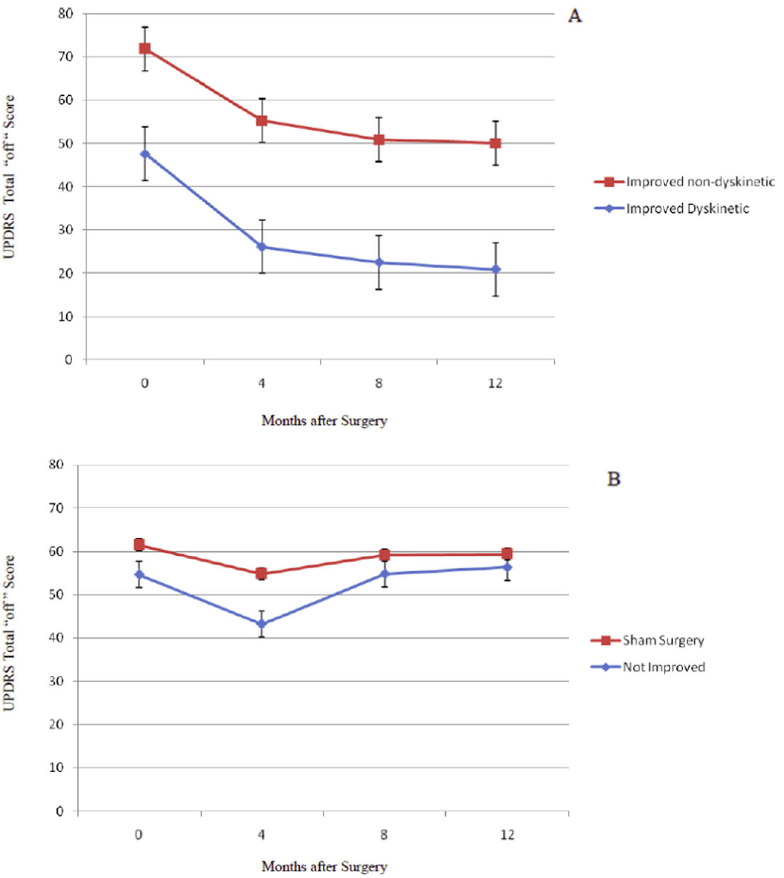
Fig. 1 Change in Total UPDRS “ off ” scores for younger transplant and sham surgery patients. The graphs present the results only in the younger 21 subjects in the clinical trial because none of the older subjects developed persistent dyskinesias. This fi gure shows the